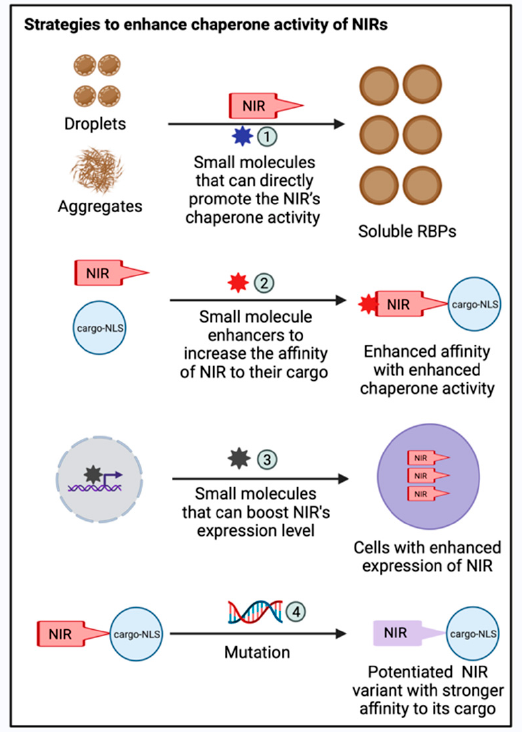
Figure 3. Therapeutic strategies to enhance the chaperone activity of NIRs. Various therapeutic strategies can be applied to enhance the chaperone activities of NIRs against mislocalized and aggregated RBPs: (1) Screening for drug-like molecules that can improve NIR’s ability to prevent or reverse RBP fibrillization; (2) Designing small molecule enhancers that can increase the affinity of NIRs to their cargo; (3) Screening small molecules that can boost the expression level of NIRs in cell-based models; and (4) Exploiting complex structure information of NIR bound to their cargo to develop potentiated NIR variants with stronger affinity towards their cargo. This figure was created with